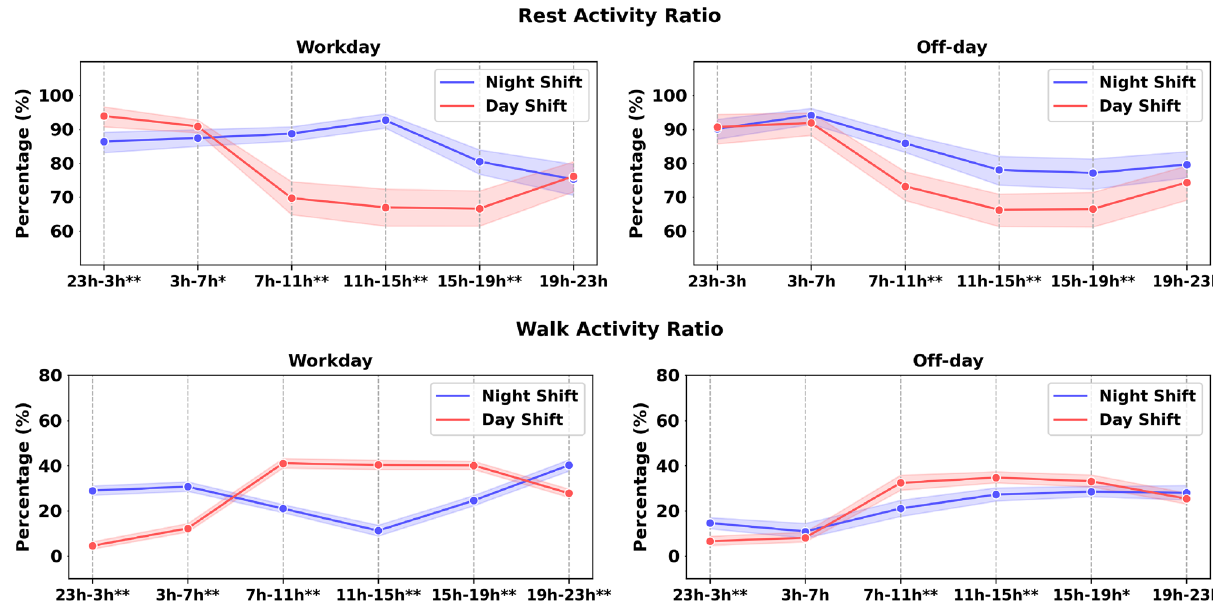
Figure 2. Comparison of the physical activity from different time periods in a day. The x-axis presents the time in a day. The decision to use these time intervals is described in the method section. Asterisks indicate statistical differences at each time period with p ∗∗ < 0.01 , p ∗ < 0.05